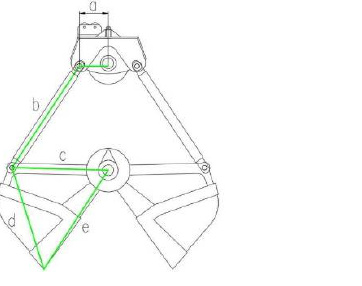
Figure 9. Track diagram of grab digging.